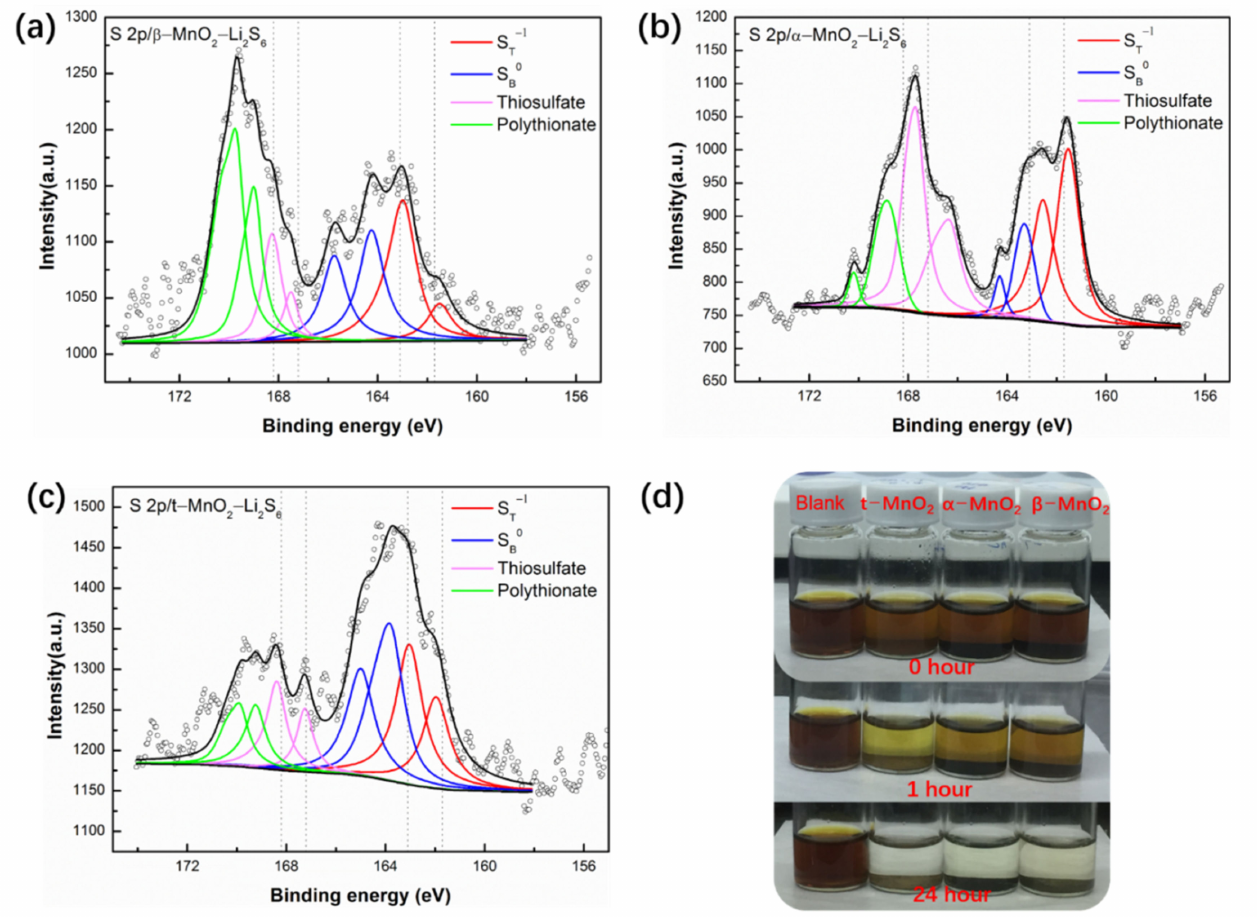
Figure 4. ( a ) S2p XPS spectra of β -MnO 2 -Li 2 S 6 ; ( b ) S2p XPS spectra of α -MnO 2 -Li 2 S 6 ; ( c ) S2p XPS spectra of t-MnO 2 -Li 2 S 6 ; ( d ) Polysulfides adsorption